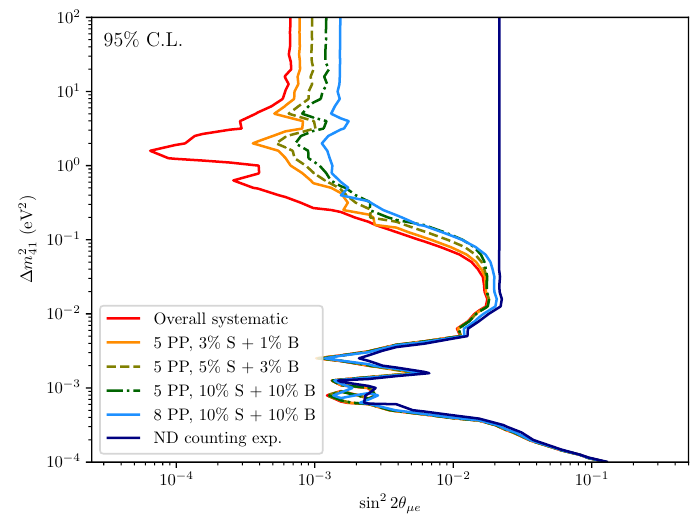
2 Figure 2 . Plot in the sin 2 (cid:18) plane: sensitivity to the sterile mixing parameters of interest (cid:22)e {(cid:1) m 41 necessary to describe the results of the LSND experiment for di(cid:11)erent choices of systematic errors. The red curve corresponds to having only overall systematics, the dark blue one accounts to having no spectral information in the near detector, while the rest of the curves correspond to introducing di(cid:11)erent levels of shape systematic uncertainties in the signal (S) and the background (B) channels for di(cid:11)erent number of pivot points (PP) where the systematics is allowed to freely